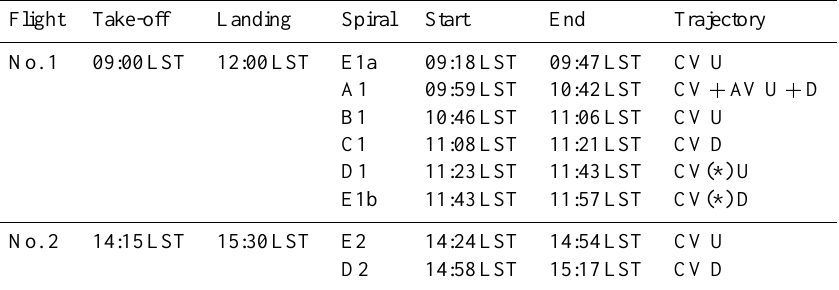
Table 1. Timings and characteristics of flights 1 and 2 performed on 23 August 2001. Single spirals are labelled according to Fig. 2a. CV and AV respectively indicate whether the trajectory explored a cross- or an along-valley-oriented section. (*) indicates that only altitude data are available. D stands for a descending (downward) flight leg and U for an ascending (upward) leg. Flight Take-off Landing Spiral Start End Trajectory No.